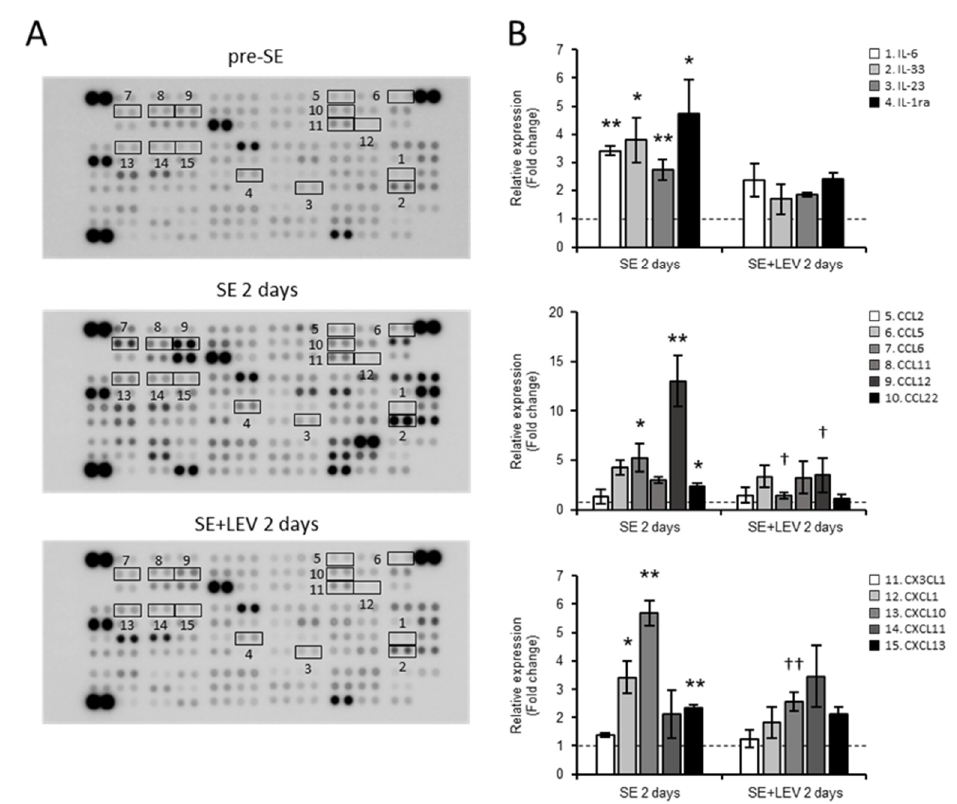
Figure 3. Alterations in the protein expression of hippocampal cytokines/chemokines after PILO-SE in mice treated with LEV or untreated. Protein extracts from the hippocampi of LEV-treated mice and untreated PILO-SE mice at 2 days post-SE or pre-SE were analyzed using the Proteome Profiler Array, Mouse XL Cytokine Array Kit (ARY028 R&D System), which contained 111 different capture antibodies spotted in duplicate on a nitrocellulose membrane. ( A ) Representative images of array membranes corresponding to pre-SE (upper panel), SE 2 days (middle panel) and SE + LEV 2 days (lower panel). Fifteen factors surrounded by squares were selected as representative cytokines/chemokines, and the quantified values at 2 days post-SE divided by those of the pre-SE are shown in ( B ). All data points represent the mean ± SEM of three independent experiments ( n = 3). Data were analyzed for significant differences by one-way ANOVA and Tukey’s post-hoc test. Results with p values < 0.05 were considered statistically significant. ** p < 0.01, * p < 0.05 vs. pre-SE mice, †† p < 0.01, † p < 0.05 vs. without post-SE mice.